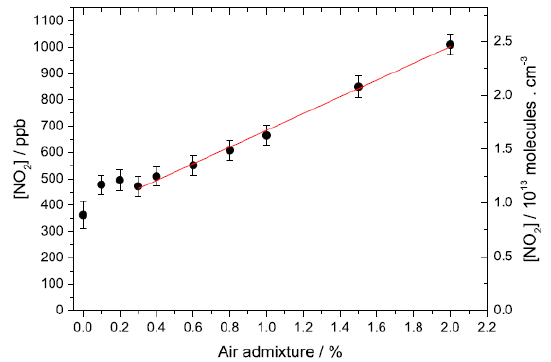
Figure 24. Absolute concentration of NO 2 produced by the kinpen for different dry air admixtures [54], © IOP Publishing. Reproduced with permission. All rights reserved.